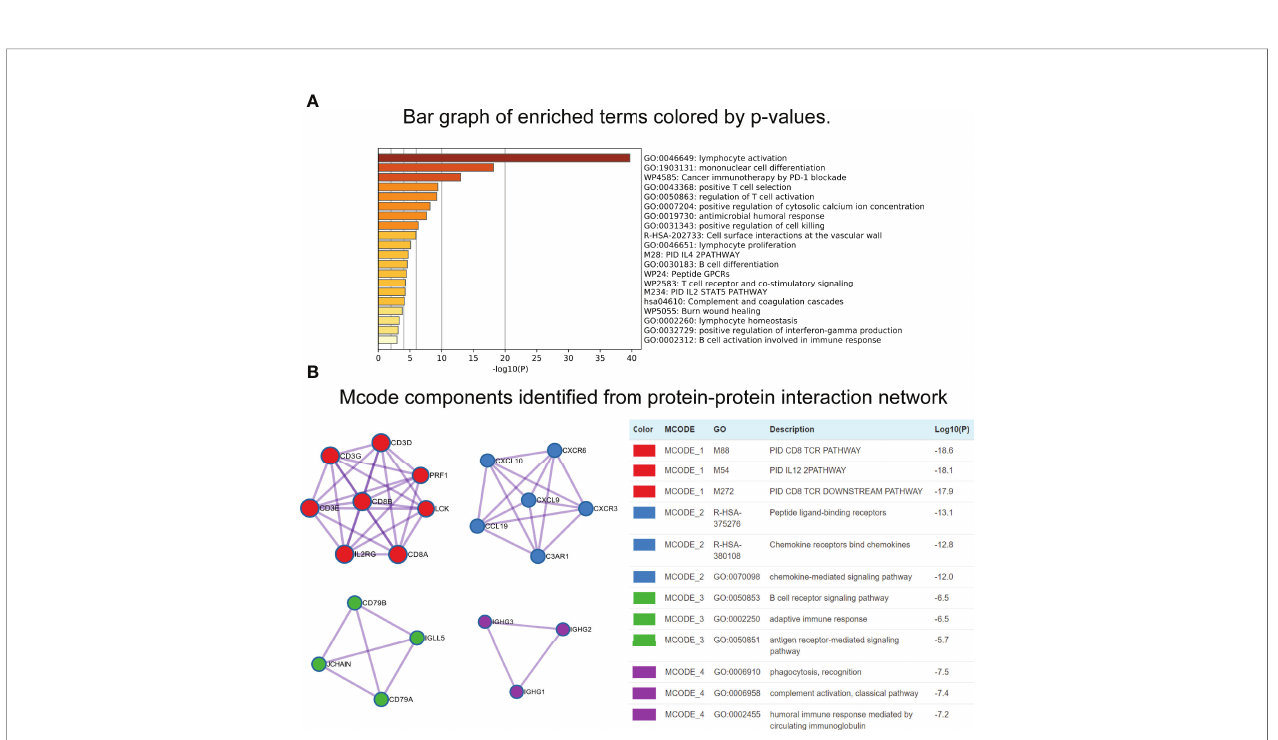
FIGURE 5 | Functional enrichment analyses of characteristic genes. (A) Bar graph of enriched terms. (B) Mcode components identi fi ed from Protein-protein interaction (PPI) network.